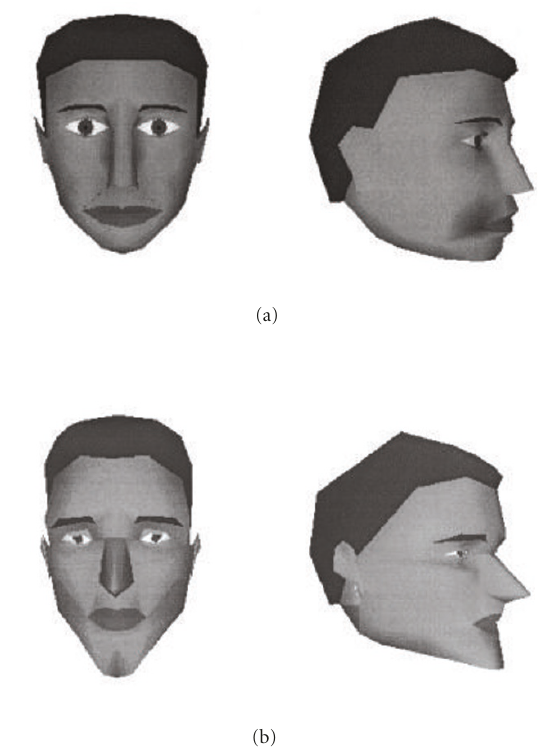
Figure 3: Human face adaption using CSRBF proposed by Lavagetto and Pockaj